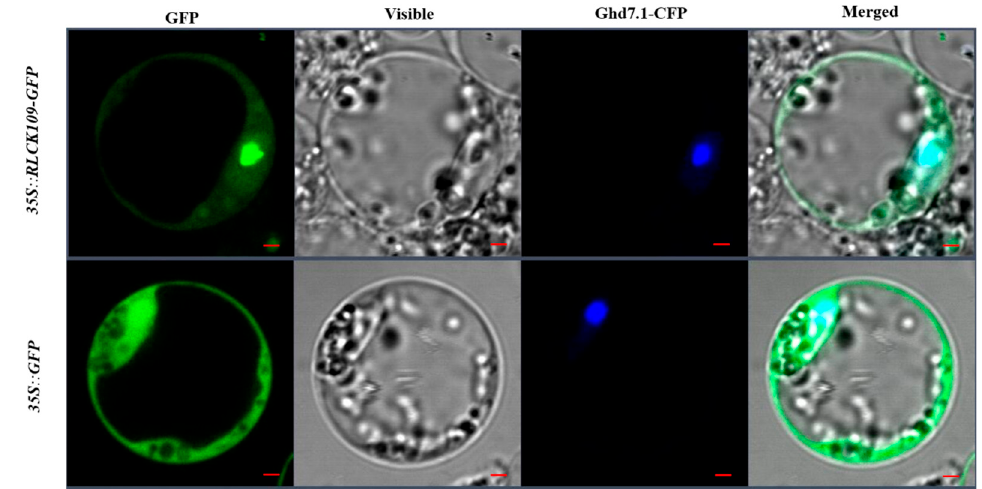
Figure 8. Subcellular localization of OsRLCK109. 35S::RLCK109-GFP , RLCK109 fused to GFP; 35S::GFP , empty GFP; Ghd7.1-CFP, nucleus marker. Scale bar: 2 µ